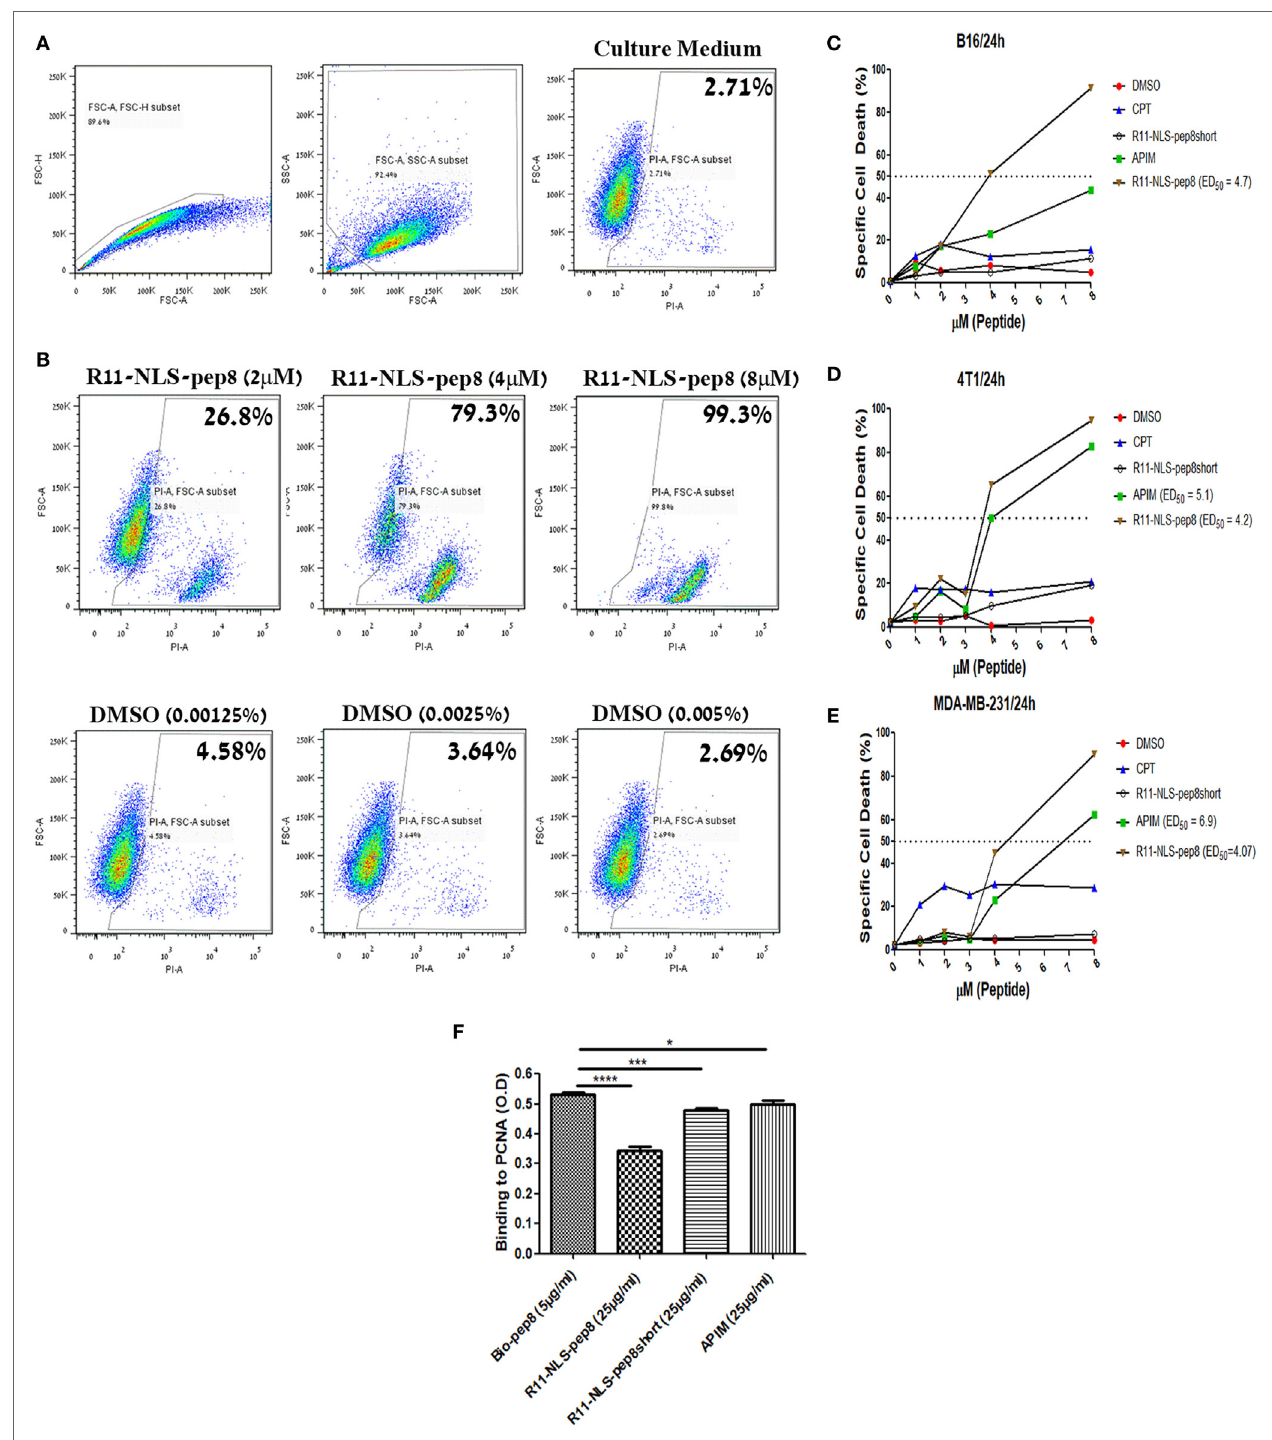
FigUre 4 | Flow cytometry based cell death assay of R11-NLS-pep8. Flow cytometry based cell death assay using PI was employed. (a) Gating strategy of cancer cell line for the detection of PI positive (dead) cells in culture medium, (B) representative dot plots for the effect of R11-NLS-pep8 on cell death relative to equivalent DMSO percentages. (c) Cell death assay of murine B16 cell line, (D) cell death assay of murine 4T1 cell line, (e) cell death assay of human MDA-MB-231 cell line. Camptothecin and APIM peptide were used as positive control; R11-NLS-pep8short was used as a negative control. ED50 was calculated using a sigmoidal dose–response curve only for treatments that have shown to induce cell death above 50% after 24 h. (F) ELISA-based assay to investigate pep8 binding site to proliferating cell nuclear antigen. R11-NLS-pep8 was employed as positive control and R11-NLS-pep8short served as a negative control. Unpaired t -test, * p < 0.05, ** p < 0.01, and *** p <